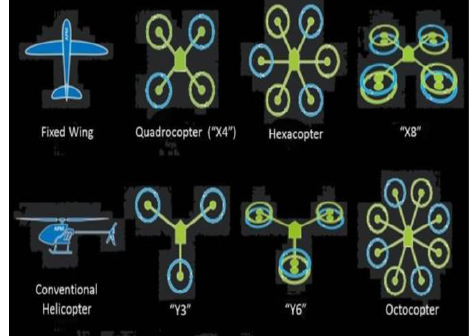
Figure.1. General flow chart for 3D mapping using UAV (Source: